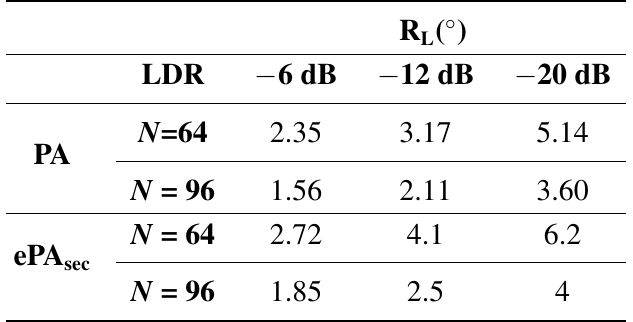
for arrays with 64 and 96 sec